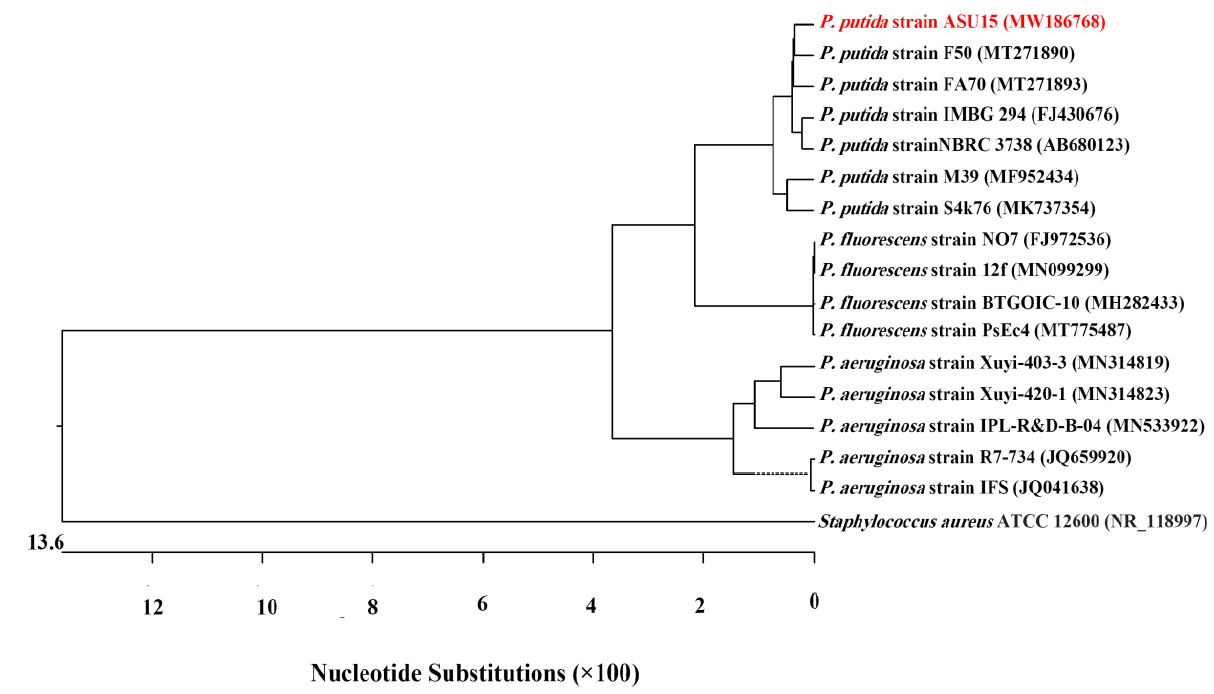
Figure 2. Molecular phylogenetic tree of 16S rRNA gene sequence of Pseudomonas putida strain ASU15 (red font) with related referential bacterial strains in GenBank database were constructed by the Neighbor-Joining method using MegAlign software (ver. 5.01). Staphylococcus aureus strain ATCC 12,600 (NR_118997) was used as an out-group. Accession numbers of the National Center for Biotechnology Information (NCBI) database of each strain are given in brackets.